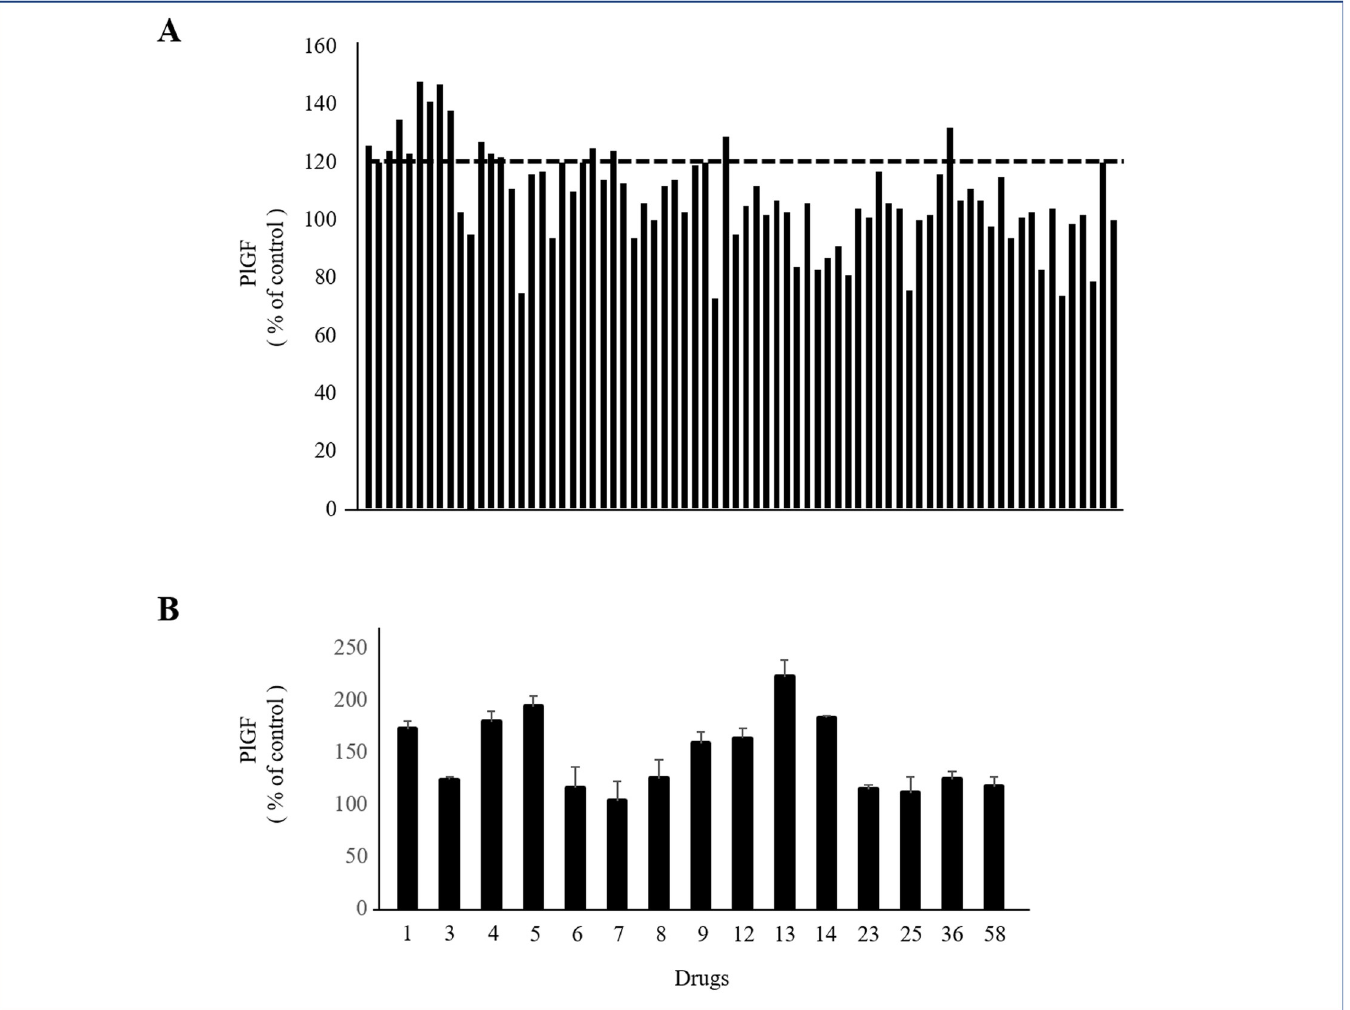
Fig 1. Production of PlGF from HUVECs treated with a library of Kampo drugs. A : First screening. PlGF concentrations produced by 74 drugs. B : Second screening. PlGF concentrations produced by 15 drugs increased PlGF by more than 120 above the control in the first screening. 1: Kakkonto; 3: Otsujito; 4: Anchusan; 5: Hachimijiogan; 6: Daisaikoto; 7: Saikokeishito; 8: Saikokeishikankyoto; 9: Saikokaryukotsuboreito; 12: Shoseiryuto; 13: Shofusan 14: Tokishakuyakusan 23: Shichimotsukokato; 25: Juzentaihoto; 36: Bofutsushosan; 58: Sansoninto. PlGF, placental growth factor; HUVECs, human umbilical vein endothelial